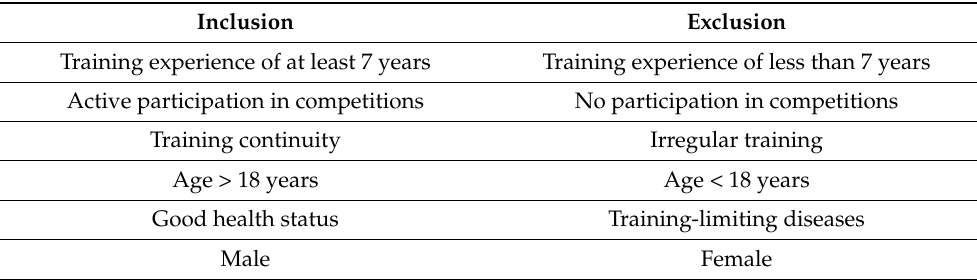
Table 1. Inclusion and exclusion criteria.